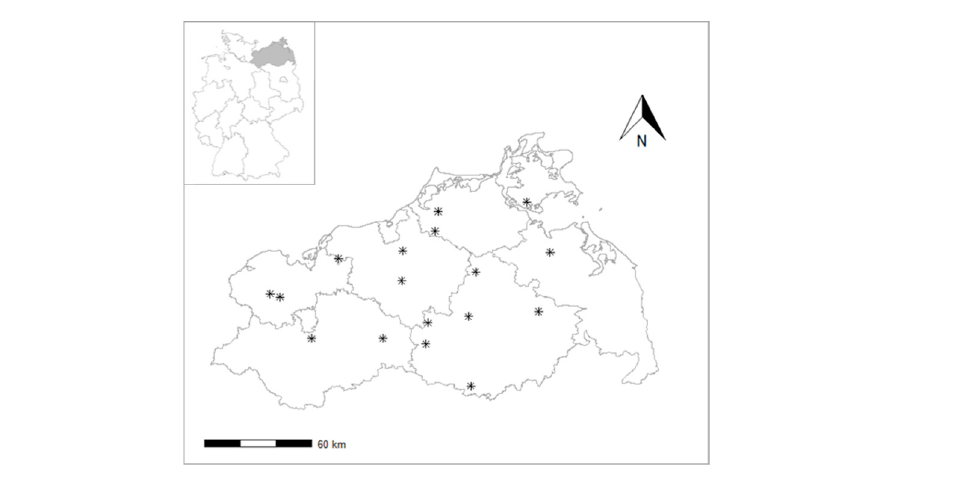
Figure 1. Location of farms (*) in the region of Mecklenburg-Vorpommern in north-eastern Germany.